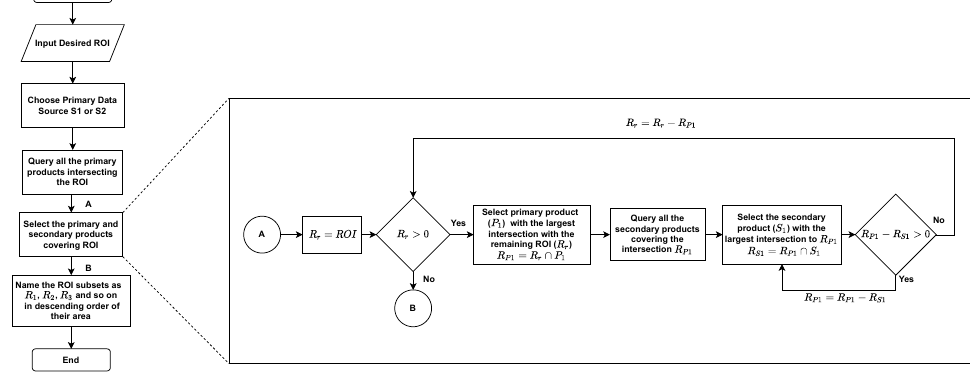
Figure 2. Flow chart for the selection of Sentinel-1 and Sentinel-2